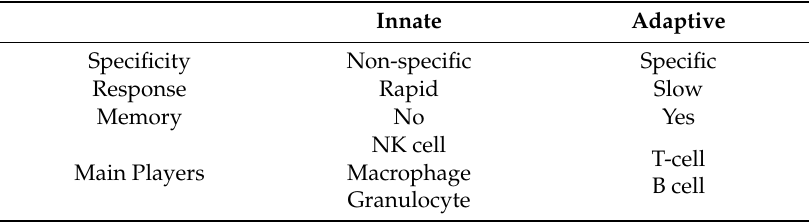
Table 1. The di ff erence between the innate and the adaptive immune